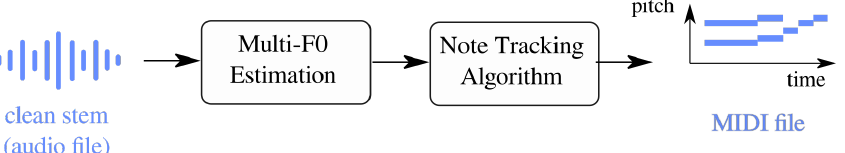
Figure 3. General block diagram of the second method described in this